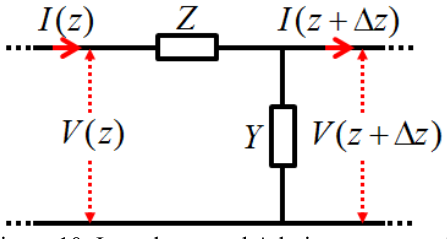
Figure 10: Impedance and Admittance network